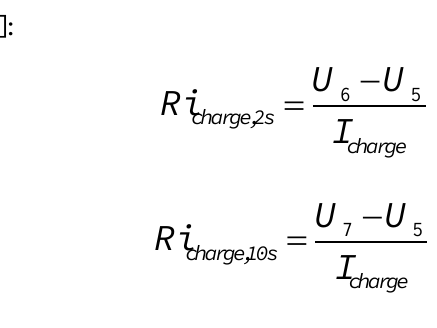
Figure 3. Measurement of internal resistance according VDA test